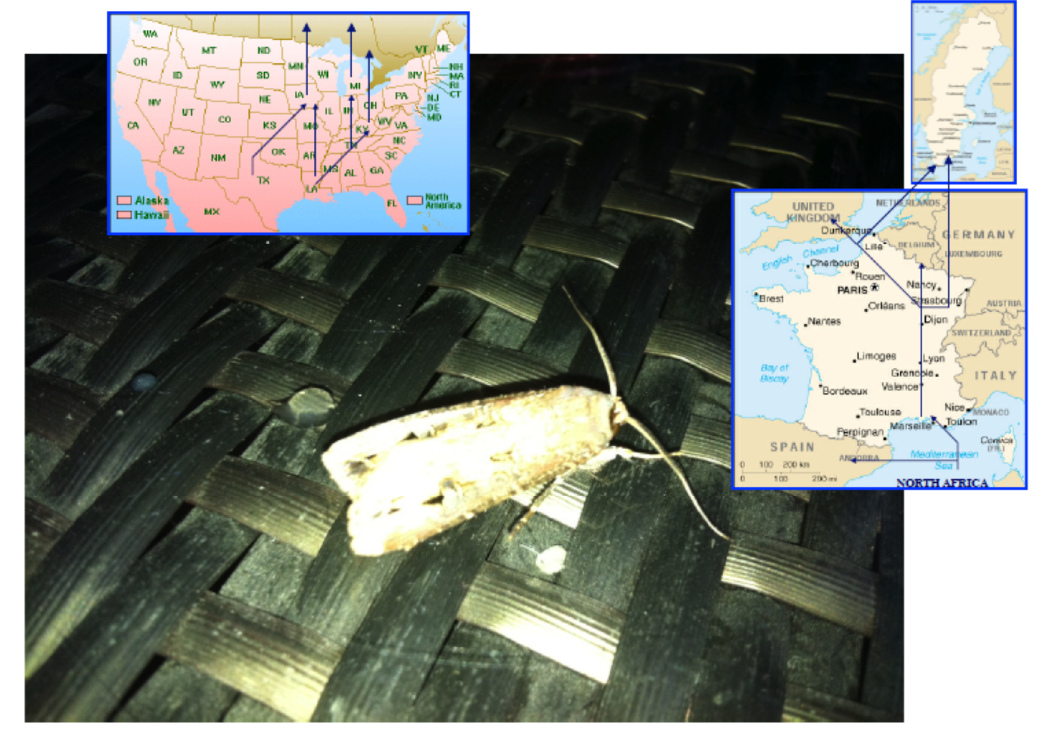
Figure 1. Migratory routes of Agrotis ipsilon on American and European continents.